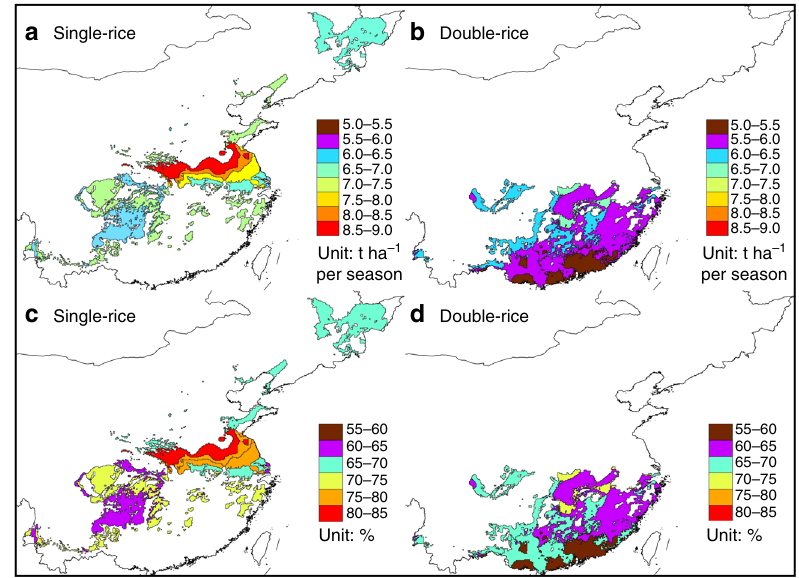
Fig. 2 Current farm yields and yield gap in China. Current farm yields as absolute values ( a , b ) or as a percentage of potential yields ( c , d ). All values are reported on a per-harvest basis and are mapped at the climate zone spatial scale. Note that there may be several climate zones within areas showing the similar current farm yield, and thus having the same color in these fi gures. Source data are provided as a Source Data fi